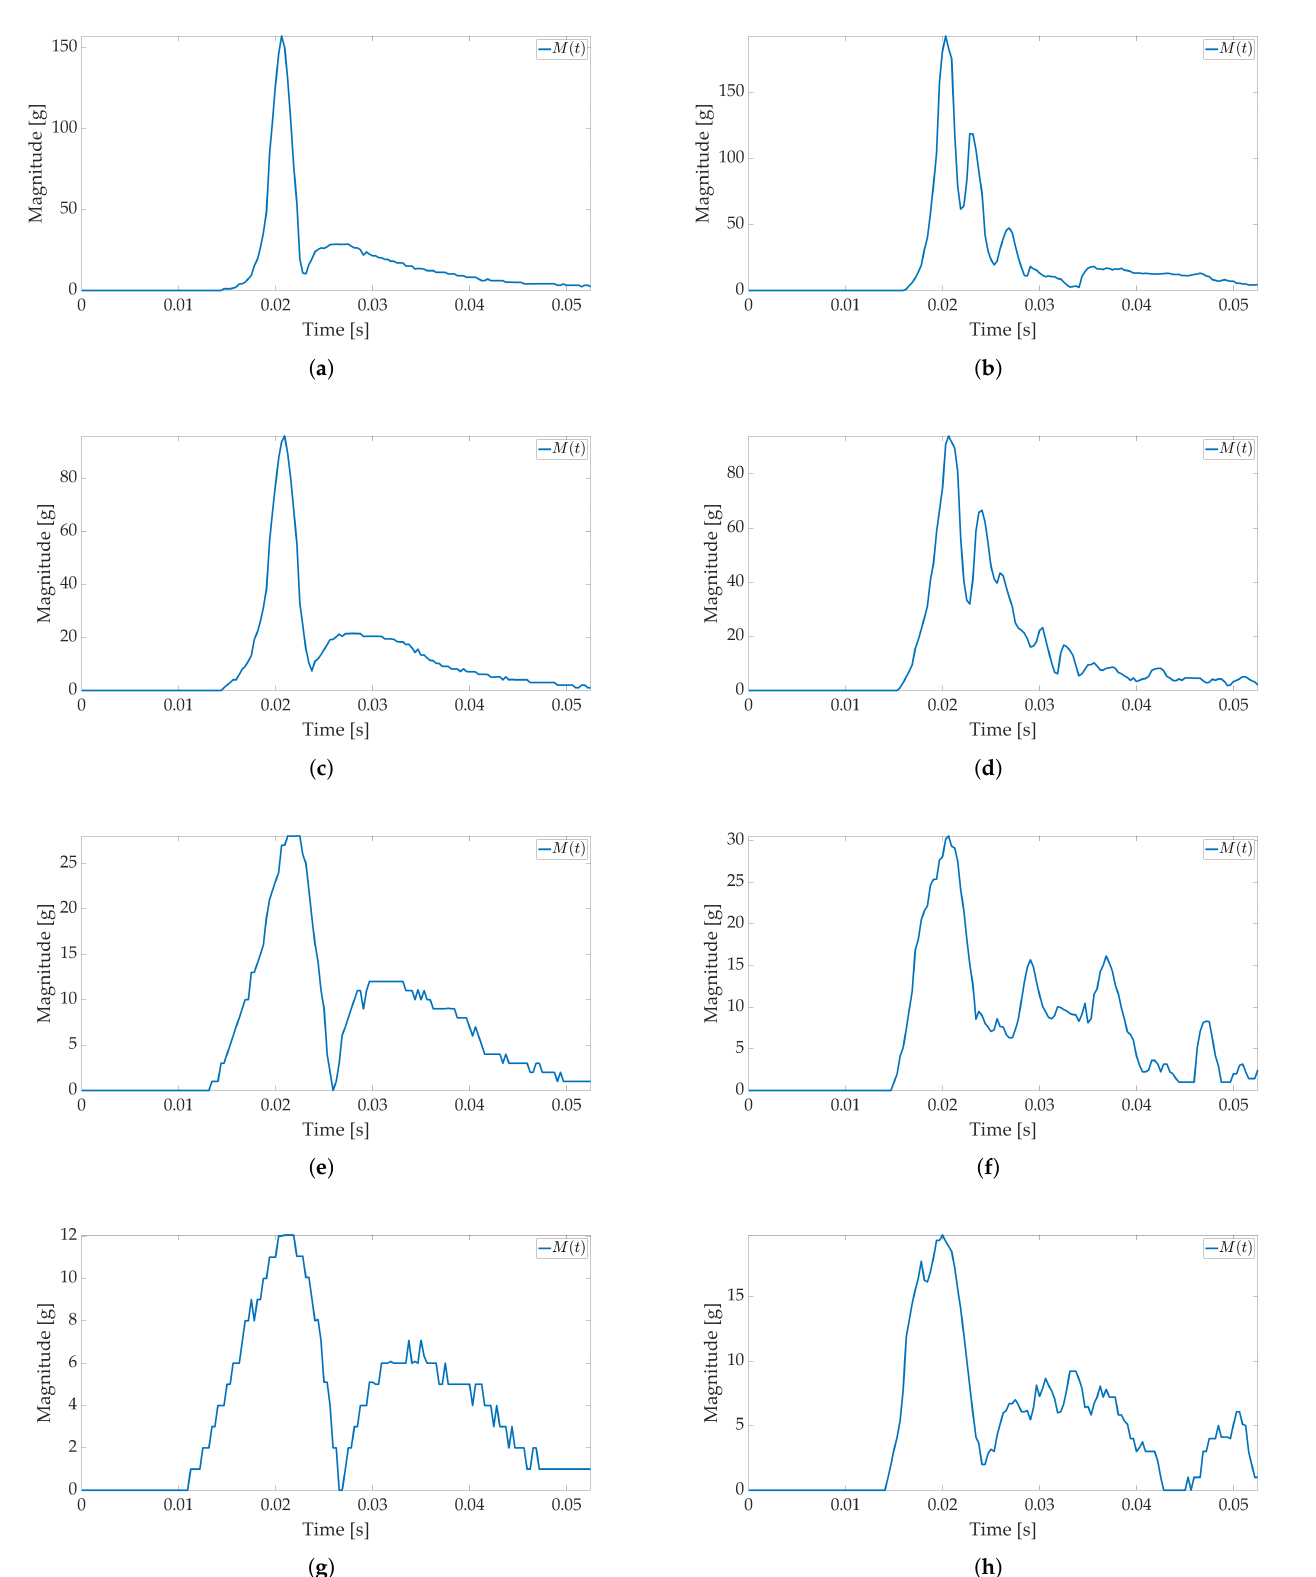
Figure 9. Shock detection values for package falling vertically from various heights (3200 Hz with FIFO). Acceleration magnitude waveform: measured inside the package on figures ( a ) (100 cm), ( c ) (50 cm), ( e ) (20 cm), ( g ) (10 cm); measured on the package on figures ( b ) (100 cm), ( d ) (50 cm), ( f ) (20 cm), ( h ) (10